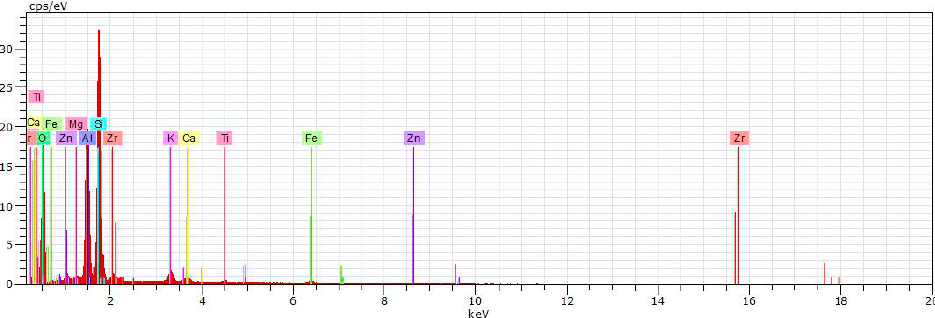
Figure 17. Energy Dispersive X-ray Spectrometer (EDS) of the ceramic tile’s hidden face.